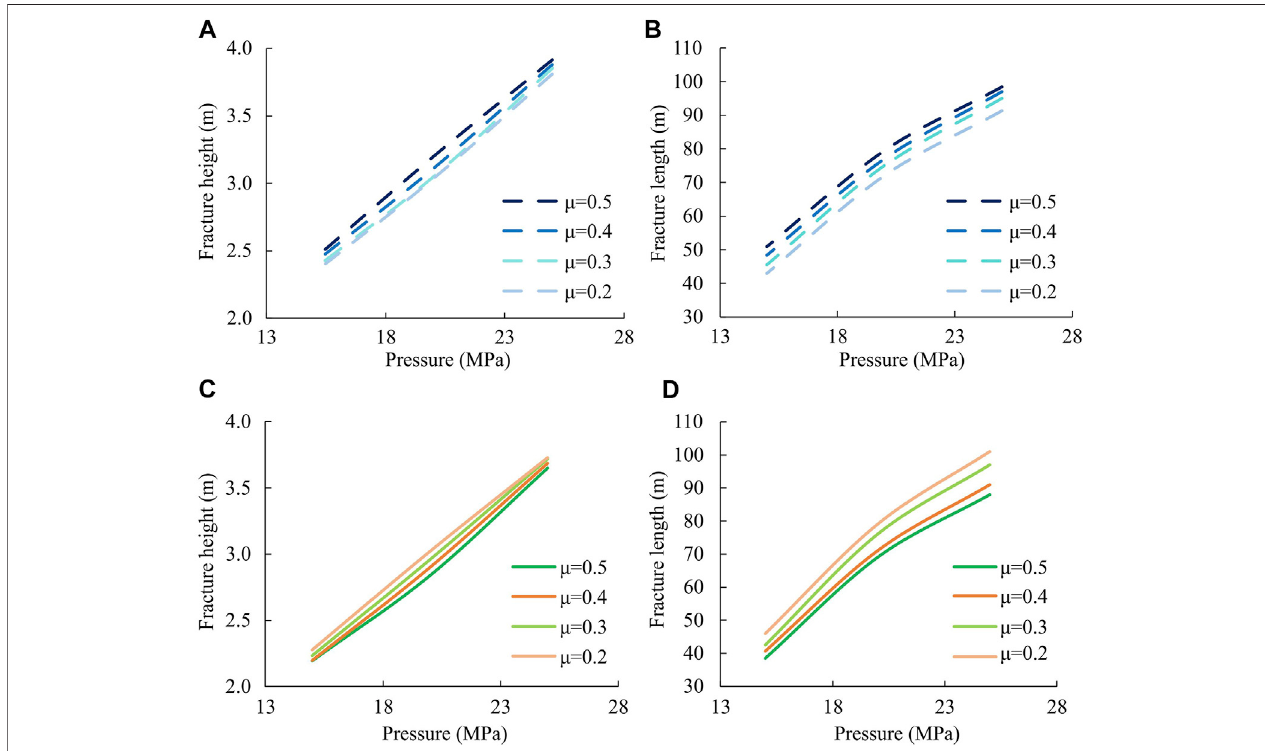
FIGURE 10| Fracture parameters under different Poisson ’ sratioof the No. 13 coal seam. (A) The fracture height of the No. 9 coal seam. (B) The fracture length of the No. 9 coal seam. (C) The fracture height of the No. 13 coal seam. (D) The fracture length of the No. 13 coal seam.